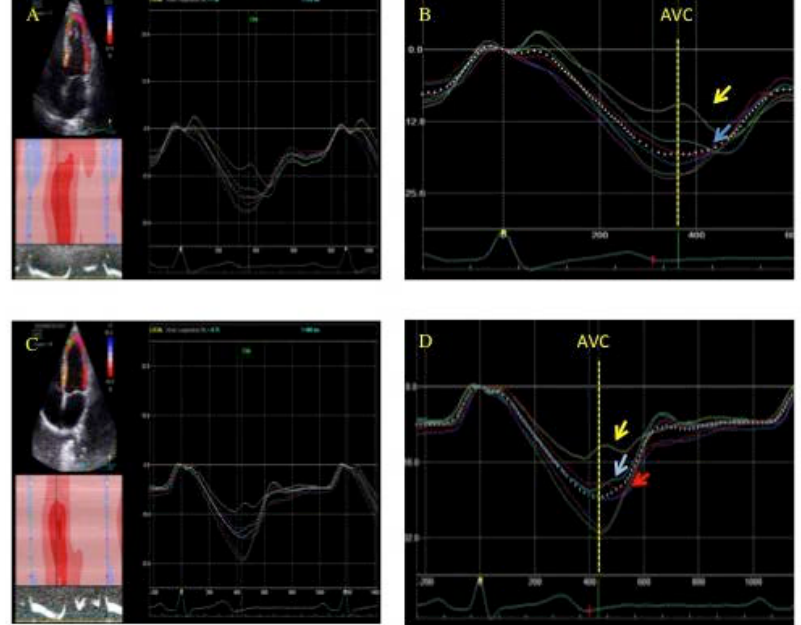
Figure 2. Postsystolic shortening (PSS) ( A ). PSS of the medial (light blue) and basal (yellow) segments of the interventricular septum, indicated by arrows in ( B ) (enlarged) ( C ). PSS of the medial (light blue) and basal (yellow) segments of the interventricular septum, and lateral basal (red) segment, indicated by arrows in ( D ) (enlarged). AVC: Aortic valve